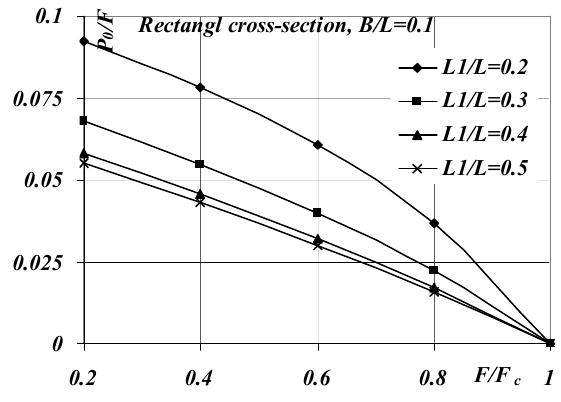
Fig 2. The limit value of bending force as a function of axial force and coordinate of cross-section with crack with rectangular cross-section is shown. Obviously that if